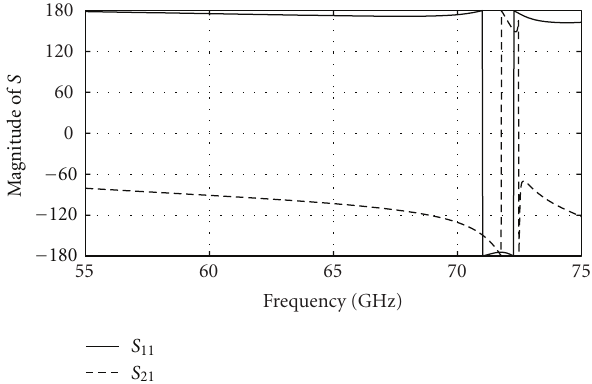
Figure 3: Phase of the transmission and reflection coe ffi cients of the square ring FSS cell.